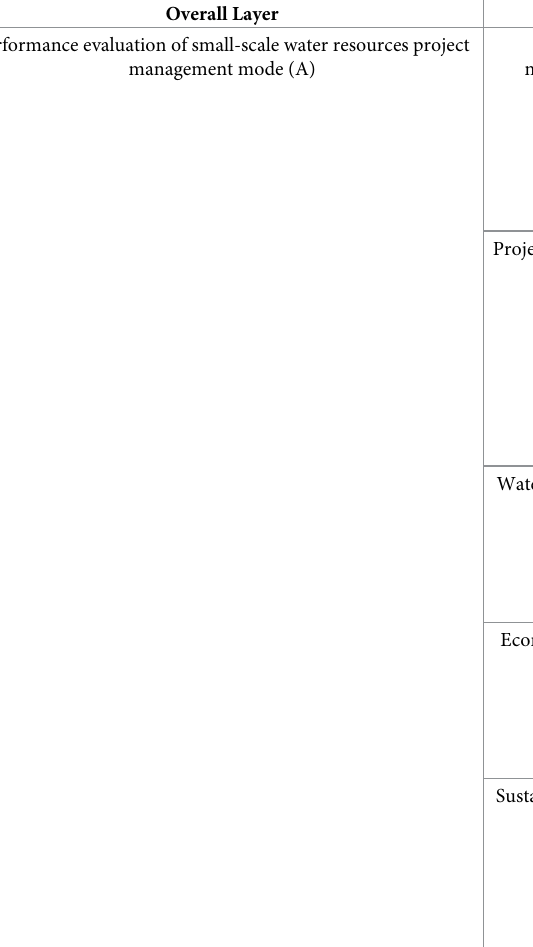
Table 3. Basic data standardization on indicators of evaluation